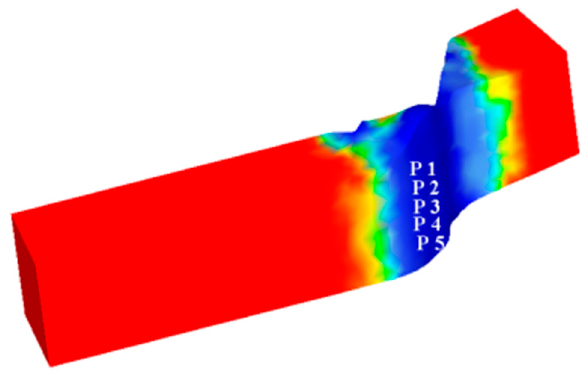
Figure 13. Tracking point location.